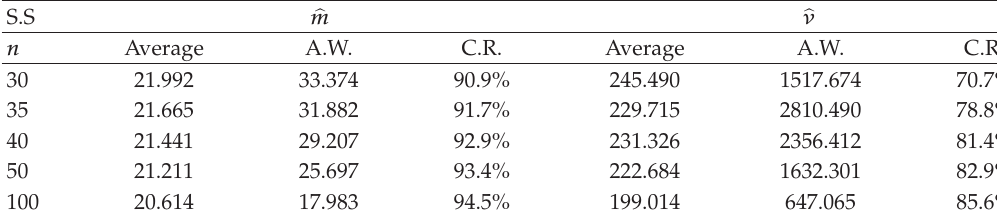
Table 1: Grouped data: τ 1 (cid:8) 2, τ 2 (cid:8) 2 . 5, τ 3 (cid:8) 3, τ 4 (cid:8) 3 . 5, τ 5 (cid:8) 4. S.S